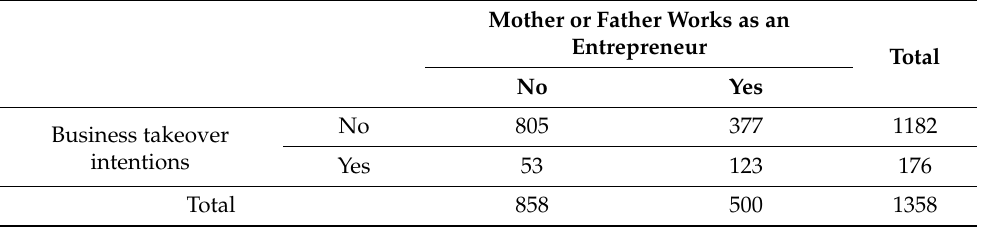
Table 3. Cross-tabulation of business takeover intentions and mother or father’s